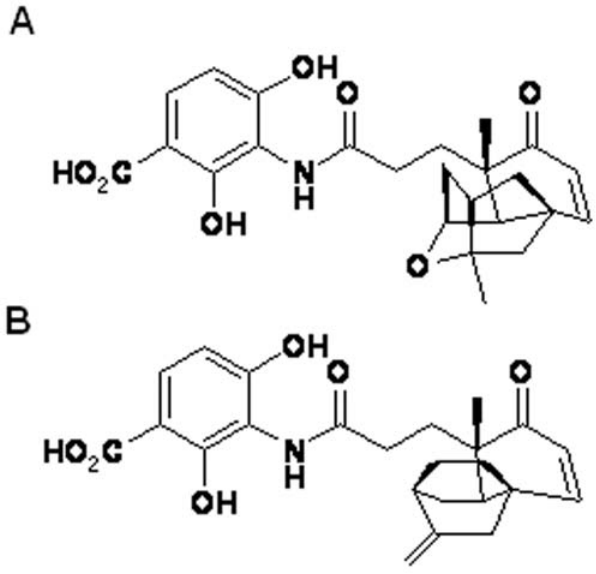
Figure 1. Structure of platensimycin (A) and platencin (B).